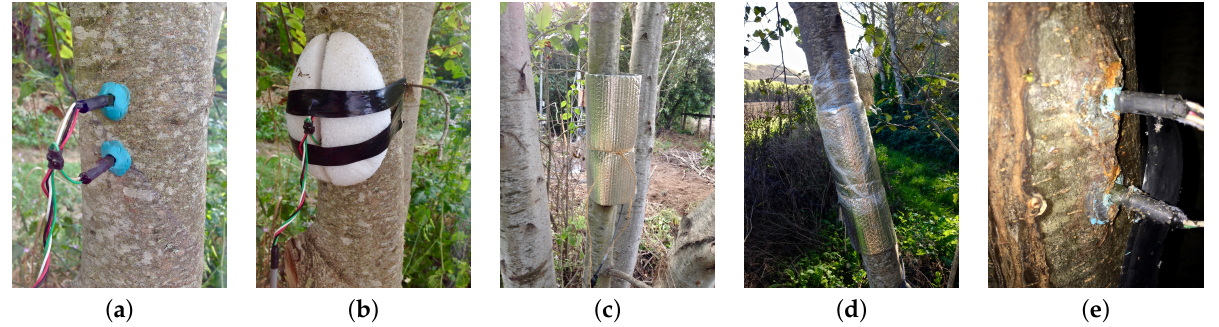
Figure 3. Pictures of the probe installation and insulation procedure. ( a ) the dual probe after insertion into stem drill holes and sealing with putty, ( b ) foam insulation cover over probes, ( c ) reflective blanket, ( d ) saran wrapped installation, and ( e ) post-study period probe condition shown growth over